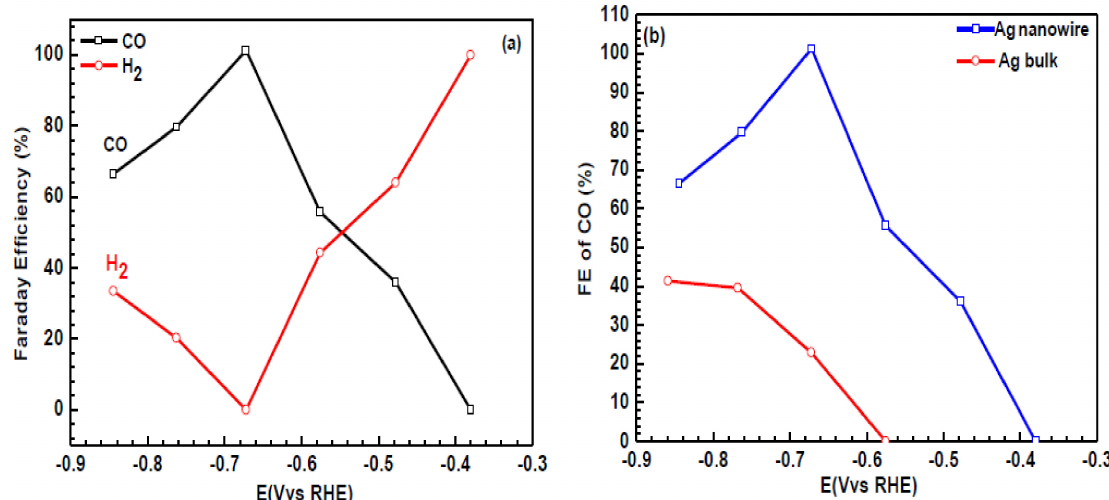
Figure 7. ( a ) FEs of gas-phase products over Ag NWs/C; ( b ) FEs of CO on applied cell potentials for Ag NWs/C and Ag bulk catalysts.